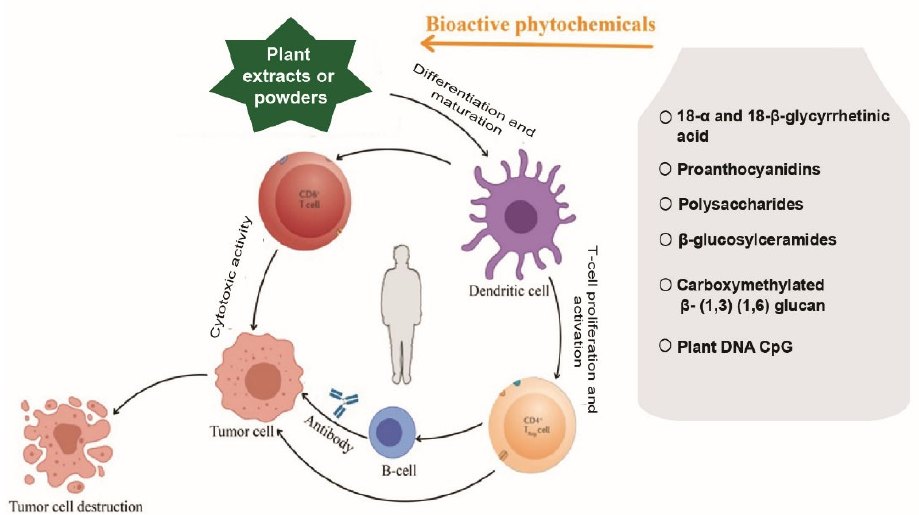
Figure 2. Schematic diagram of plants and their phytochemical-pulsed DC-based cancer immunotherapy. This illustration is modified from the previous literature [74–76]. Plant extracts or powders act on stem cells and differentiate into dendritic cells. It also acts on immature DCs and converts them to active, mature forms of DCs. Mature DCs bind with T-cells (CD4 and CD8) and initiate adaptive immune responses (humoral and cell-mediated immune responses) against tumor cells, which ultimately destroy tumor cells.